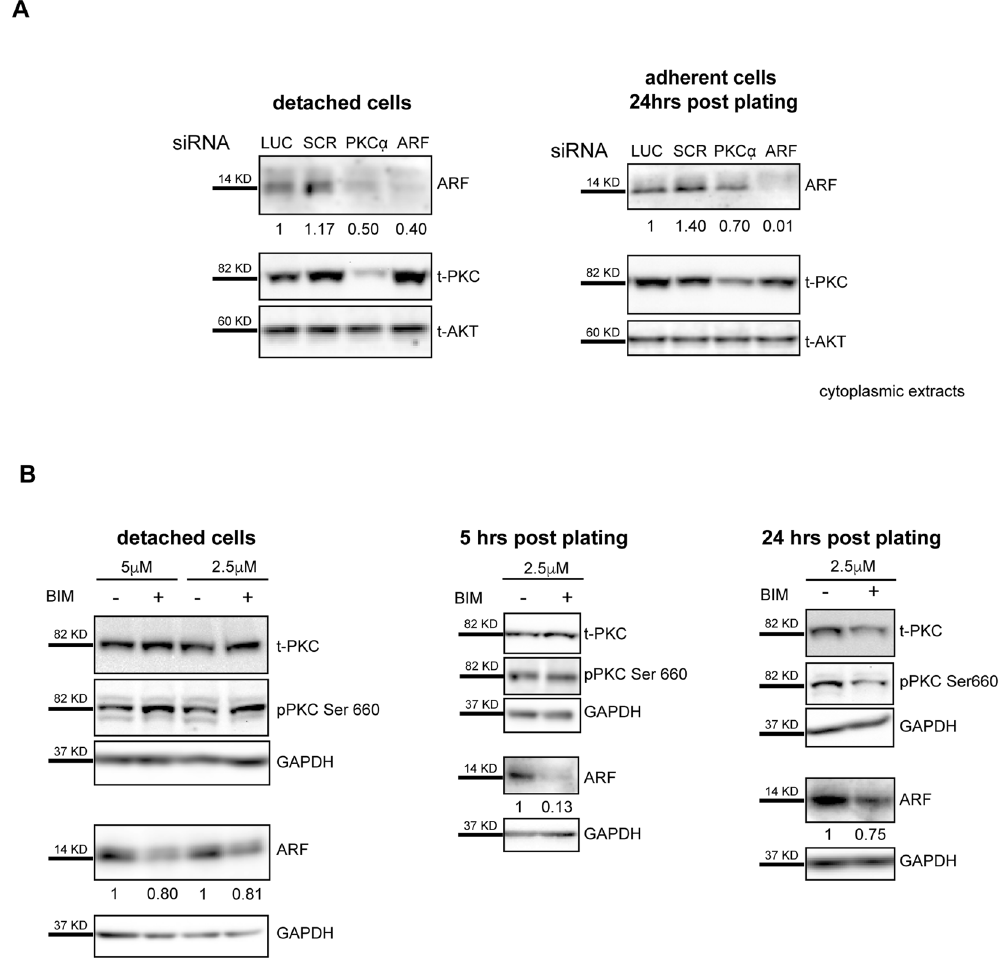
Figure 3. PKC activation is required for ARF induction. ( A ) Cytoplasmic protein extracts of cells collected before or 24 hours after plating analysed with anti ARF, t-PKC, and t-AKT (loading control) antibodies. ARF band intensities normalized versus AKT are shown as fold enrichment respect to siLUC. ( B ) Total extracts of HeLa cells treated with bisindolylmaleimide I (Bim) collected before, 5 hrs or 24 hrs after plating analysed with anti-ARF, pPKC, t-PKC and GAPDH (loading control) antibodies. Quantification of ARF band intensities has been performed as